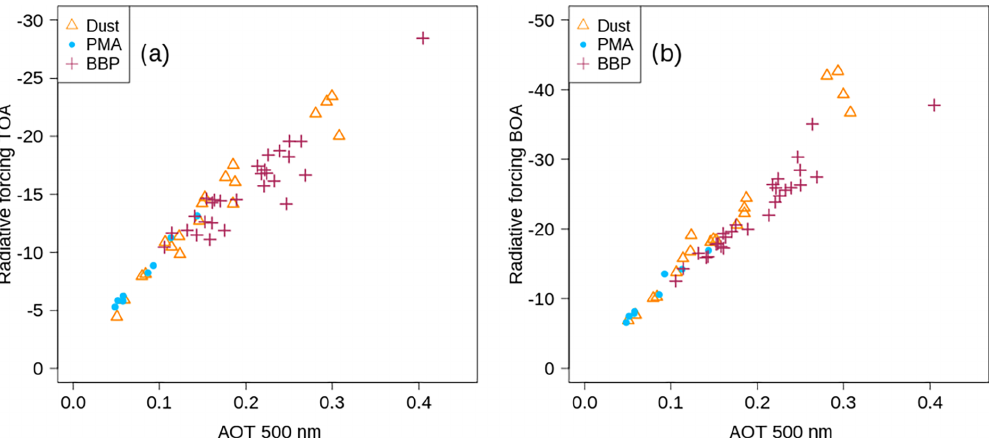
Figure 15. Aerosol radiative effect at (a) the top of the atmosphere (TOA) and (b) the bottom of the atmosphere (BOA) represented as a function of the aerosol optical thickness (AOT) for each of the major periods, retrieved from